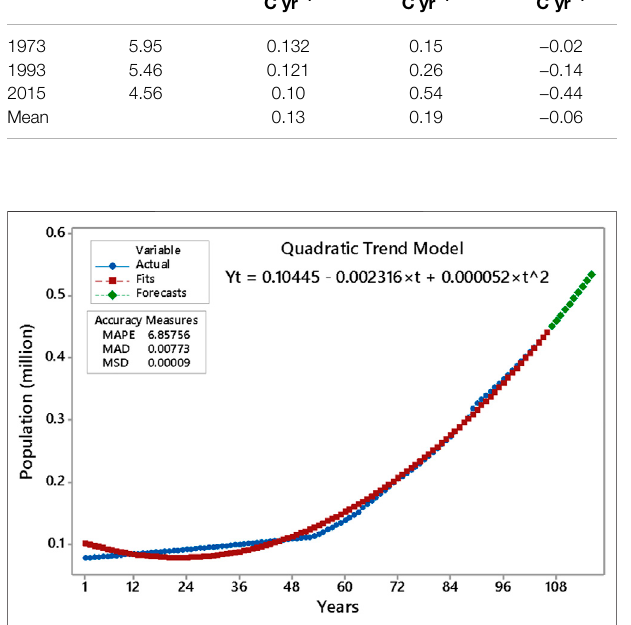
FIGURE 2 | Year-wise trend in population growth (million).